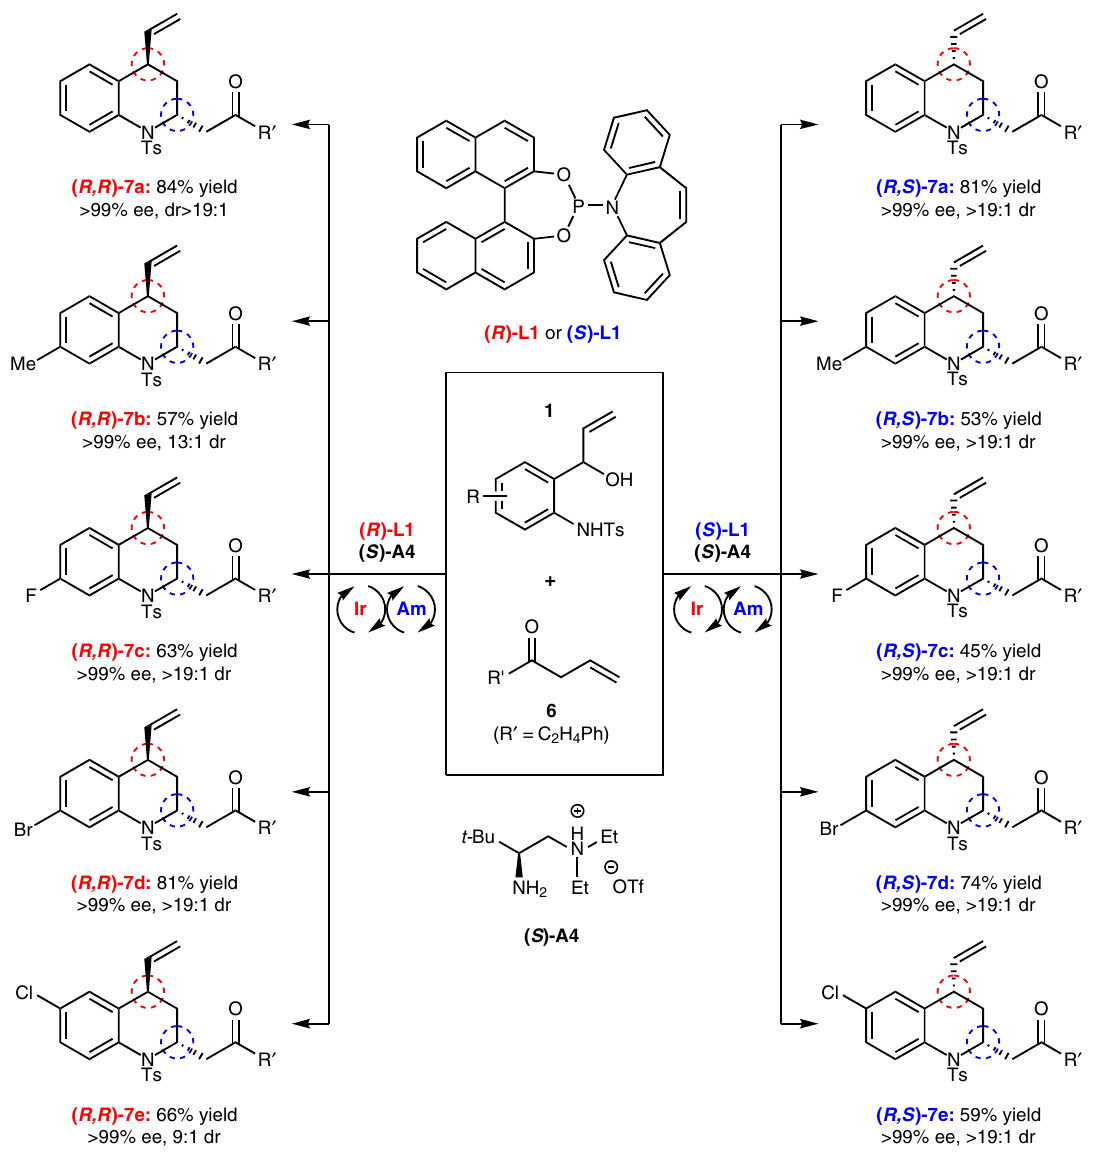
Fig. 5 Enantioselective and diastereodivergent [4 + 2] cycloadditions of vinyl aminoalcohols and β , γ -unsaturated ketones. Reaction conditions: 1 (0.25 mmol), 6 (1.25 mmol), [Ir(cod)Cl] 2 (2 mol%), ( R )-L1 or ( S )-L1 (8 mol%), amine ( S )-A4 (20 mol%), in 1,2-dichloroethane (0.3 mL) for 48 h at 50 o C; isolated yield; the values of ee and dr were determined by chiral HPLC